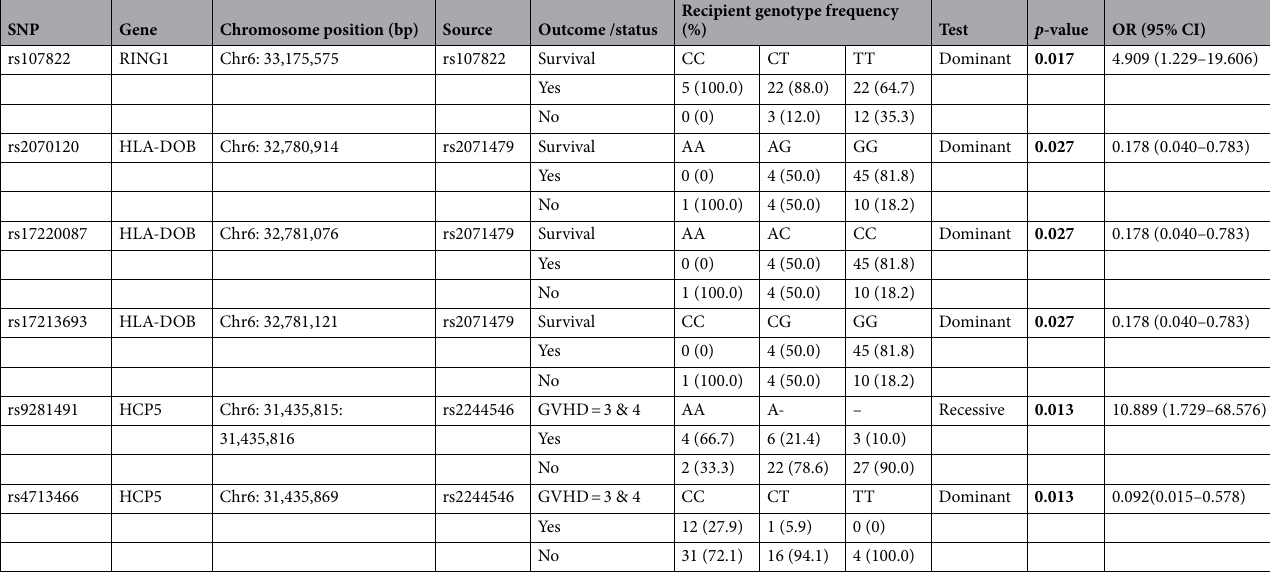
Table 5. The SNPs associated with the outcomes of unrelated CBT in recipient genotype analysis. Dominant: dominant model (AA vs. Aa + aa); Recessive: recessive model (AA + Aa vs. aa), in which “A” was defined as a higher frequency allele and the lower was “a”. Data were analyzed by Chi-square test or Fisher’s exact